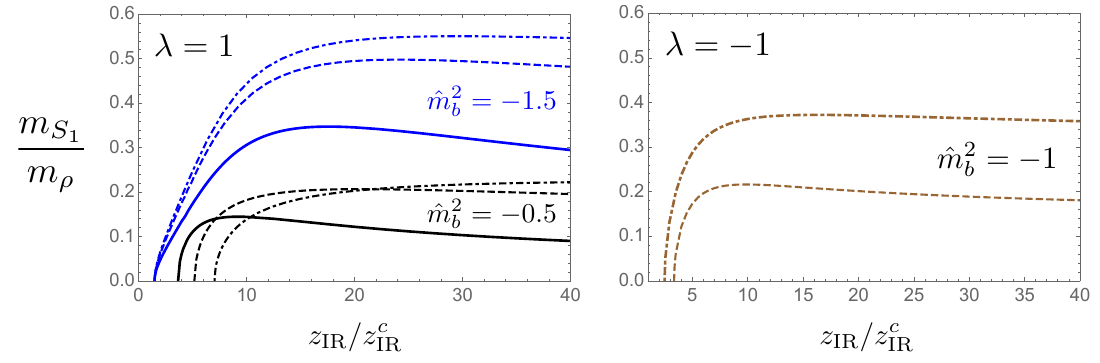
Figure 5 . Masses of the lightest singlet scalar S 1 normalized to the vector mass. We have